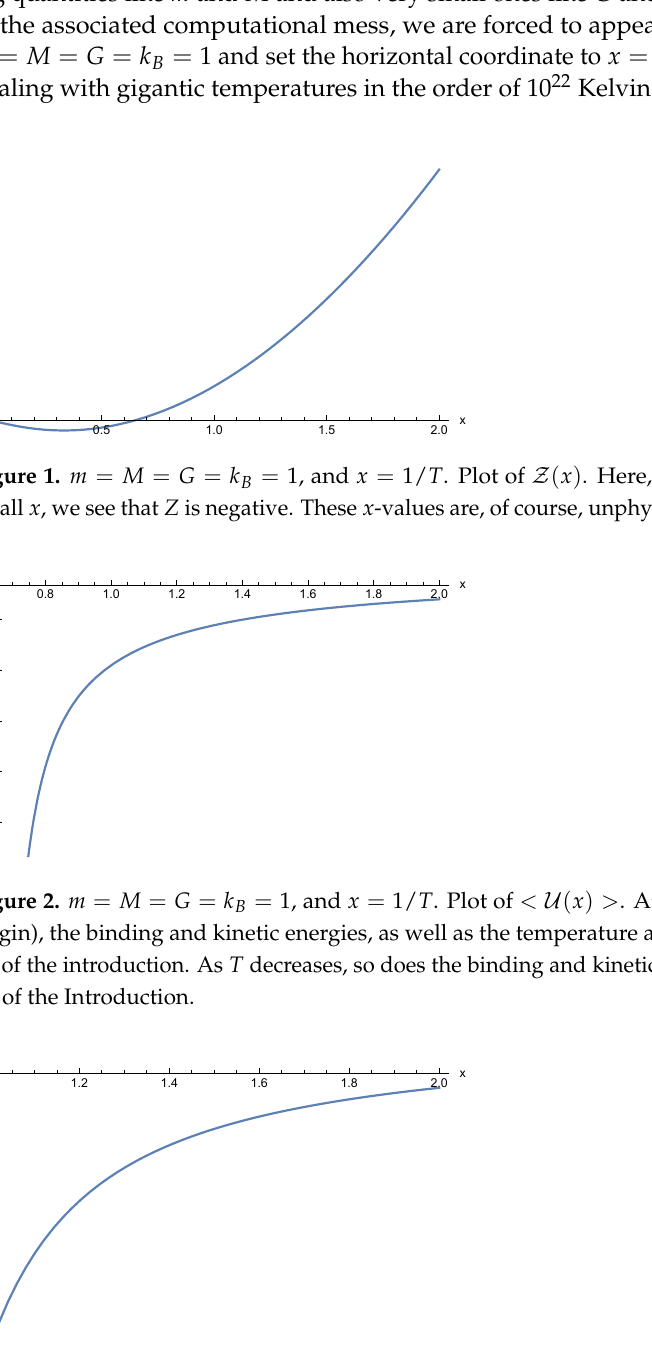
Figure 3. Plot of the specific heat C ( x ) . Here, x = β , G = m = M = 1. It is negative, as prescribed by item (3) of the Introduction. The specific heat tends to vanish as the temperature drops, as expected because of the third law of thermodynamics, that, remarkably enough, is obeyed classically here. We see that our dimensionally regularized partition function predicts the expected gravitational